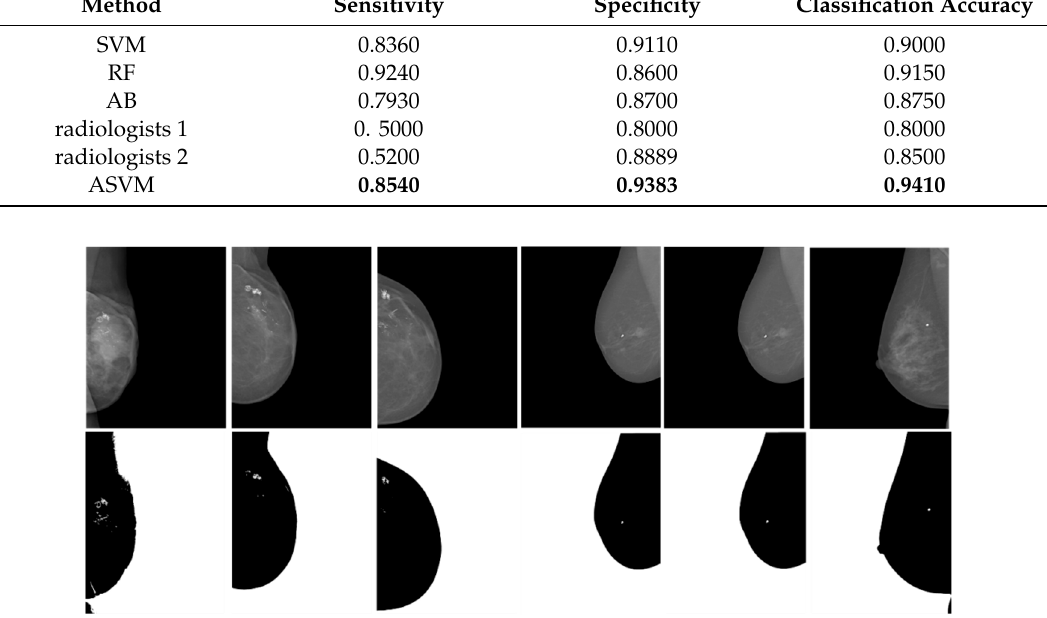
Figure 4. ROI extraction result.